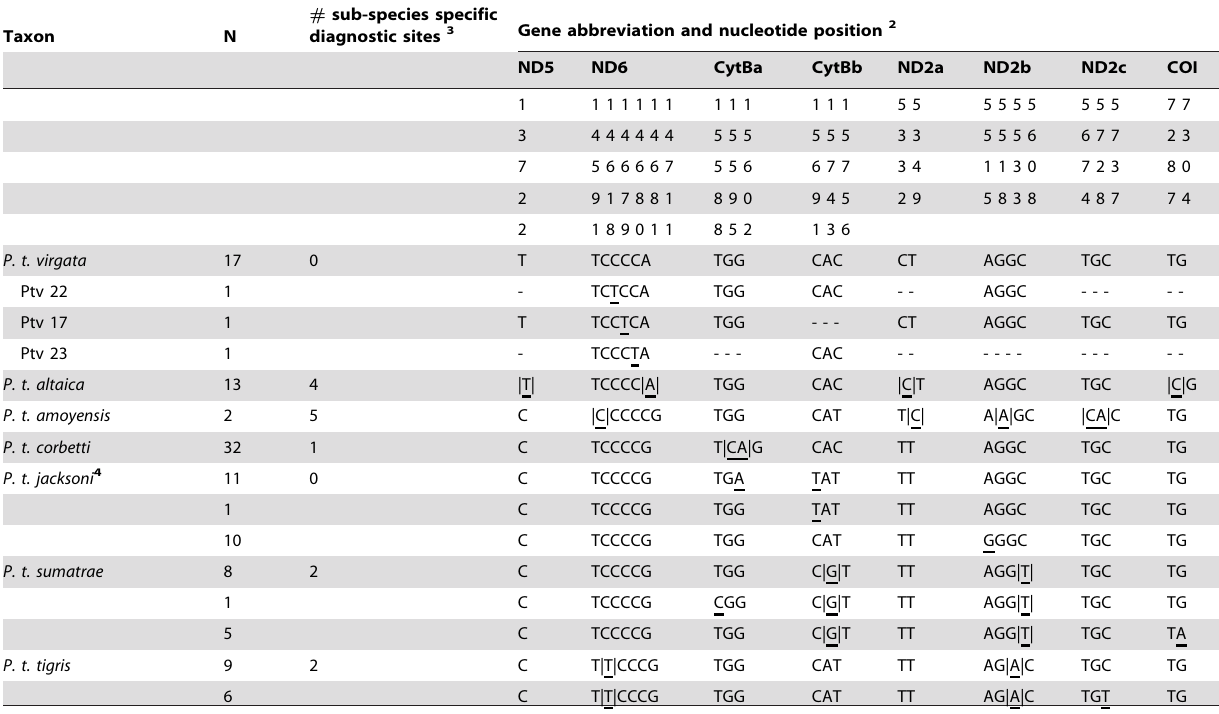
# sub-species specific Taxon N diagnostic sites 3 Gene abbreviation and nucleotide position